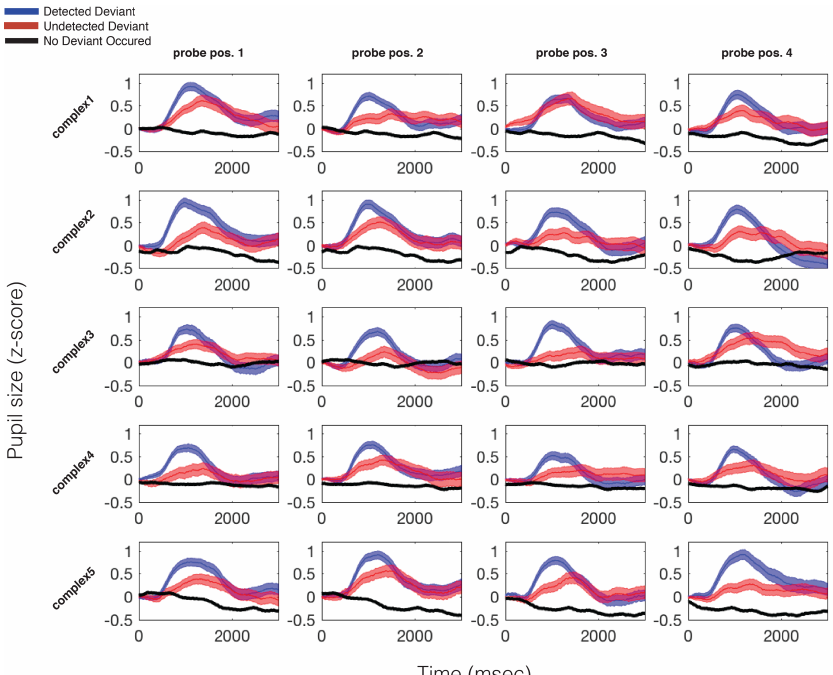
Figure 4. Average pupillary responses, across all participants, to all probed locations in all stimuli. The blue trace indicates the average pupillary response to trials during which a deviant occurred and was detected; the red trace repre- sents trials during which a deviant occurred but was not detected; the black trace indicates the same moments in time on trials in which no deviant occurred. All data are time locked to deviant onset. For no-deviant trials, this refers to the same point in time that the deviant could have occurred (but did not). Width of each trace is the standard error of the